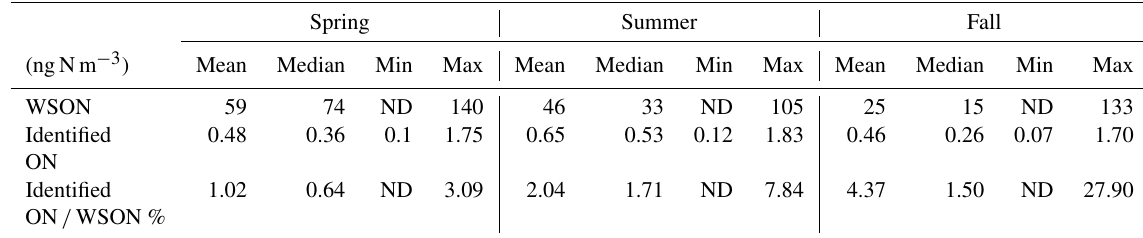
Table 4. Ratios of identified nitrogen-containing compounds (nitro-aromatics and nitrooxy-organosulfates) to WSON. Spring Summer Fall (ngNm − 3 ) Mean Median Min Max Mean Median Min Max Mean Median Min Max WSON 59 74 ND 140 46 33 ND 105 25 ND 133 Identified 0.48 0.36 0.1 1.75 0.65 ON Identified 1.02 0.64 ND ON / WSON